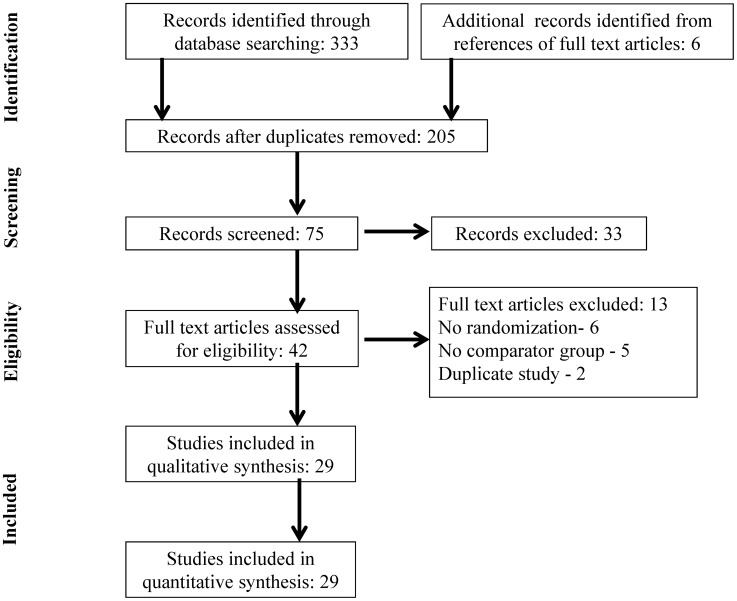
Flow diagram of selected studies.